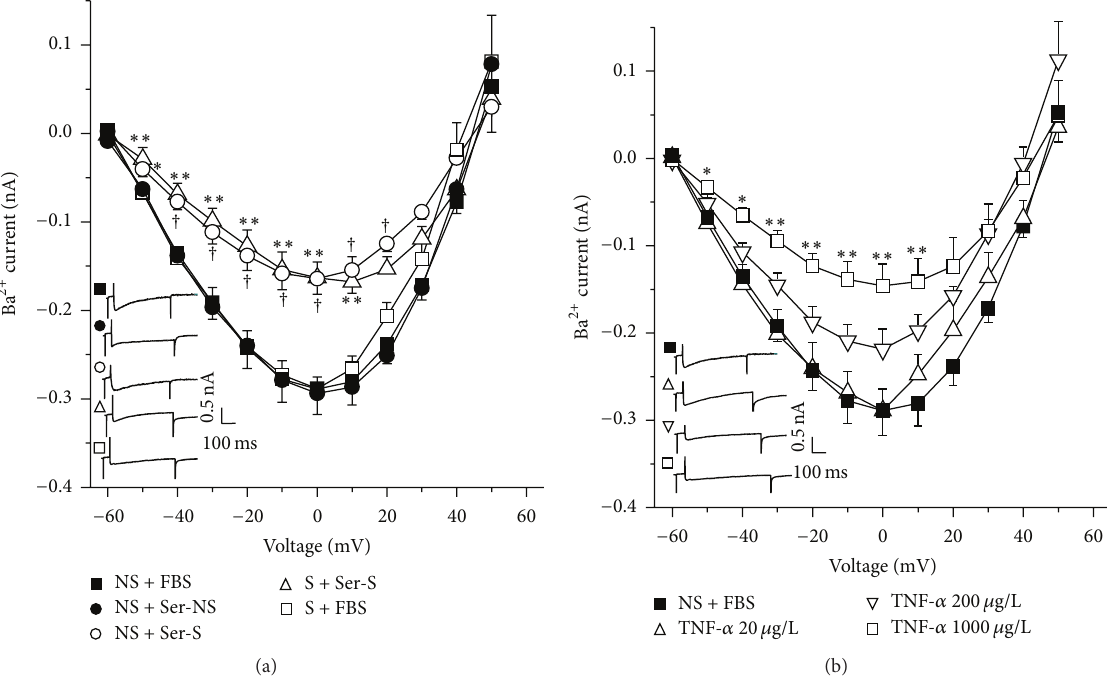
Figure 2: Voltage dependent L-type Ca 2+ currents were diminished by sensitized guinea pig serum and by TNF- 𝛼 in guinea pig tracheal myocytes. (a) Similar Ba 2+ currents, equivalent to Ca 2+ currents, induced by 10mV increments were observed in myocytes from nonsensitized (NS) animals grown with fetal bovine serum (FBS) or serum from nonsensitized guinea pigs (Ser-NS). These currents were significantly diminished when myocytes from NS and sensitized (S) animals were grown with serum from sensitized guinea pigs (Ser-S, 10%). This phenomenon was not seen when myocytes from S were grown with FBS ( 𝑛 = 9 for each group). (b) Ba 2+ currents in myocytes from NS grown with FBS showed a decrease when TNF- 𝛼 was added. These responses were concentration dependent and only the highest (1000 𝜇 g/L) produced a significant reduction of this current ( 𝑛 = 5 for each group). Insets in each figure represent original recordings. ∗ 𝑝 < 0.05 , ∗∗ 𝑝 < 0.01 , and † 𝑝 < 0.01 when compared with NS + FBS group. Symbols represent mean ±